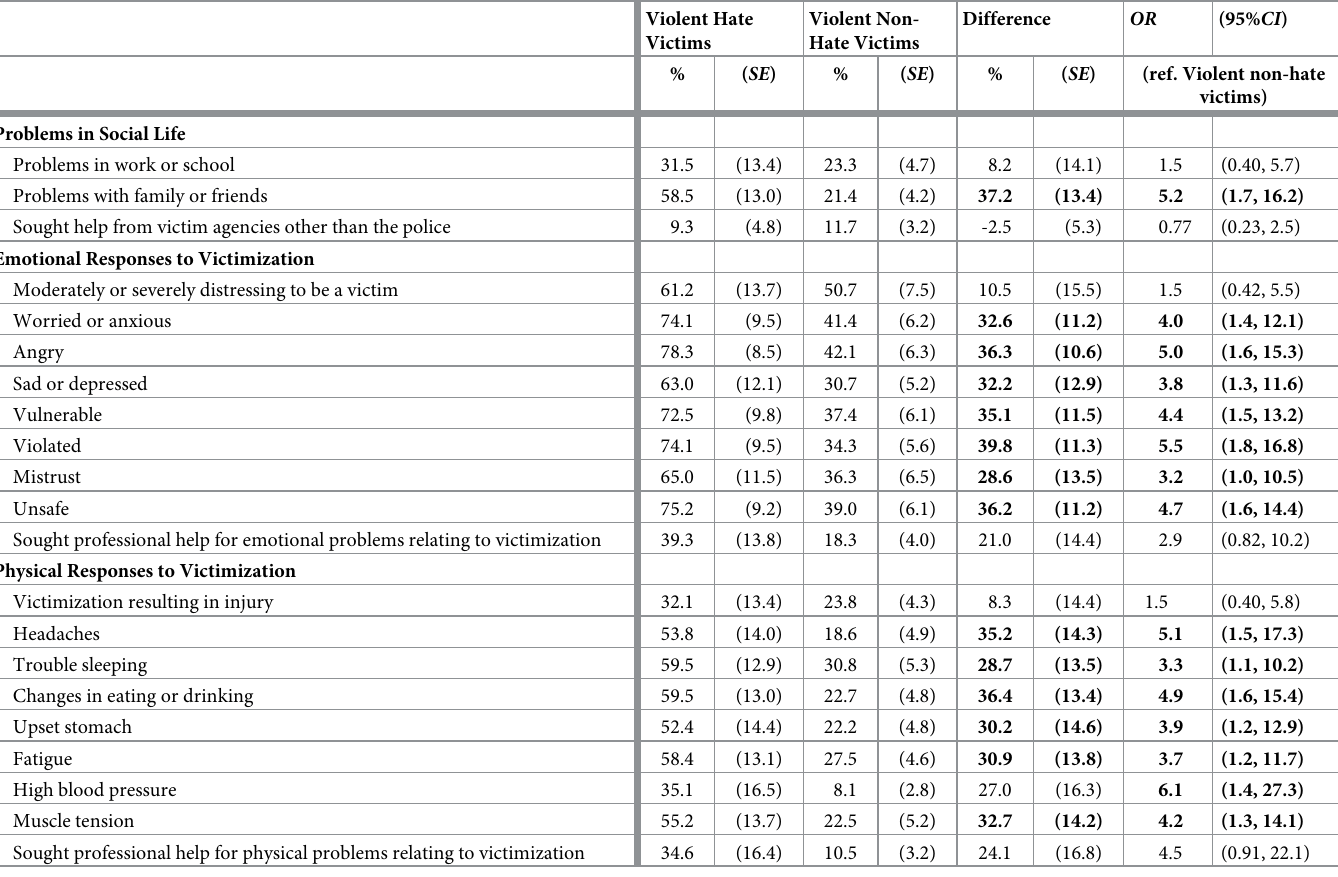
Table 3. Effects of victimization of violent hate and non-hate crime among LGBT victims, United States, National Crime Victimization Survey